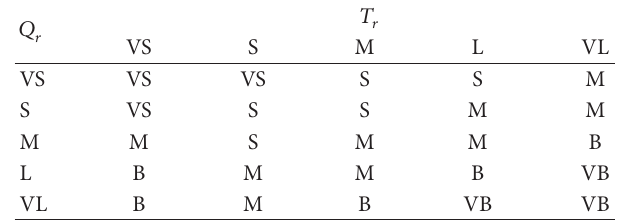
Figure 4: The membership function of input variable 𝑄 𝑟 .